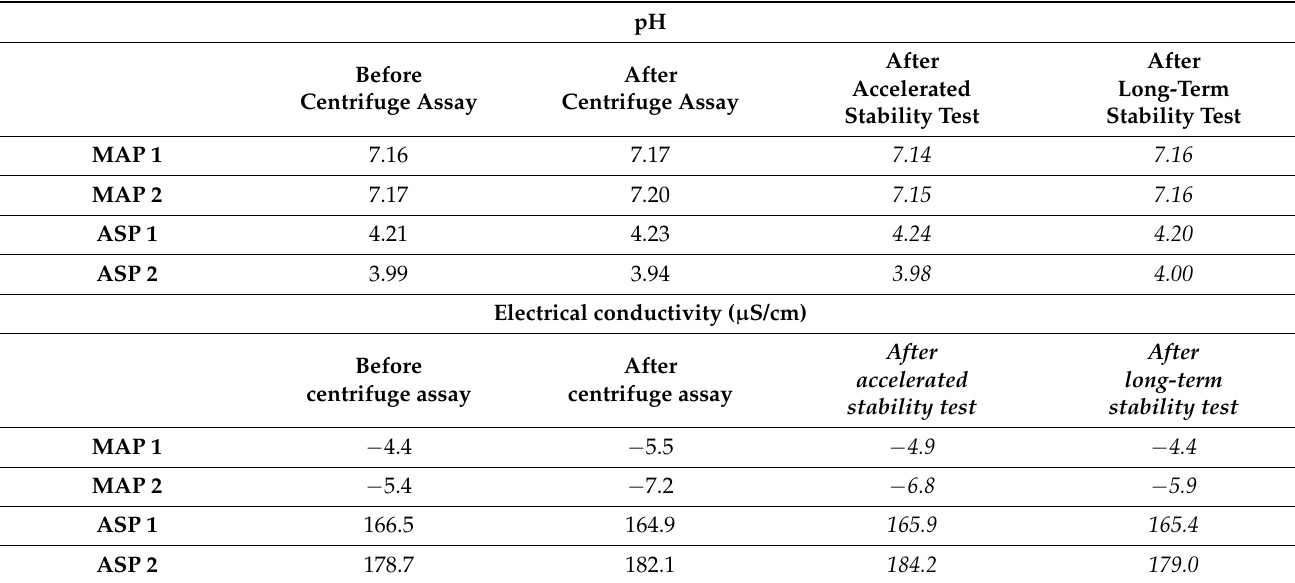
Table 3. pH and electrical conductivity ( µ S/cm) values of emulgel samples before and after a centrifuge assay, as well as after an accelerated and long-term stability test. pH